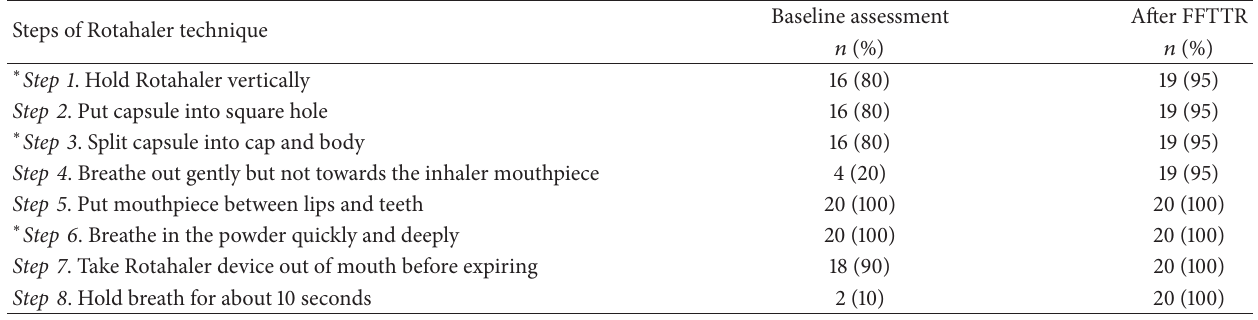
Table 3: Comparison of correct Rotahaler technique at baseline assessment and after FFTTR ( 𝑛 = 20 ). Steps of Rotahaler